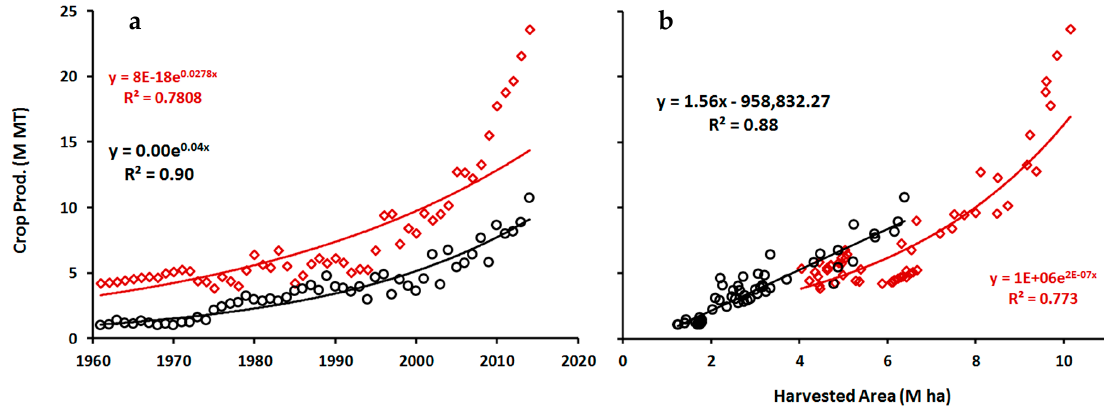
Figure 18. ( a ) Time series graphs of national annual crop production data in Ethiopia and Tanzania for 1993–2015. Source: [1]. Note the exponential growth rate of crop production data in Ethiopian relative to that of Tanzania. ( b ) Exponential fit of crop production as a function of harvested area for Ethiopia (red squares) and linear fit of that of Tanzania (black circles) for 1961–2014. Note the inability of the exponential curve to explain this relationship in Ethiopia that crop production tremendously increases while harvested area saturates.